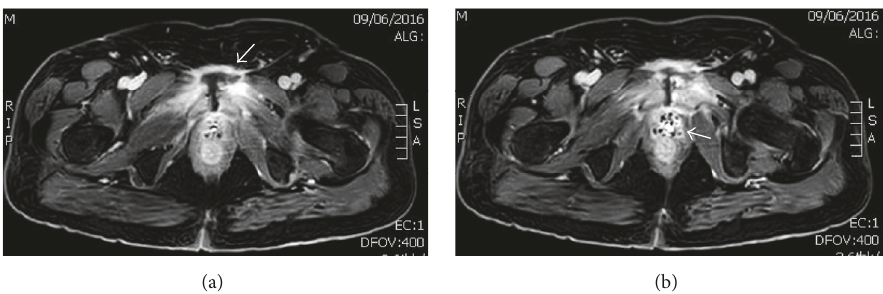
Figure 2: MRIaxial imaging of theabdomen and pelvis pre- and postadministration of intravenous Dotarem (cid:2) contrast. (a) Further distention of the symphysis pubis joint secondary to an increase in size of an abscess within it (arrow), measuring 3.8 ∗ 1 .8 cm, compared to previous measurement of 2.0 ∗ 1 .5 cm. (b) Apparent pocket of air around the prostatic urethra (arrow) likely representing susceptibility artifact from surgical sutures rather than actual gas